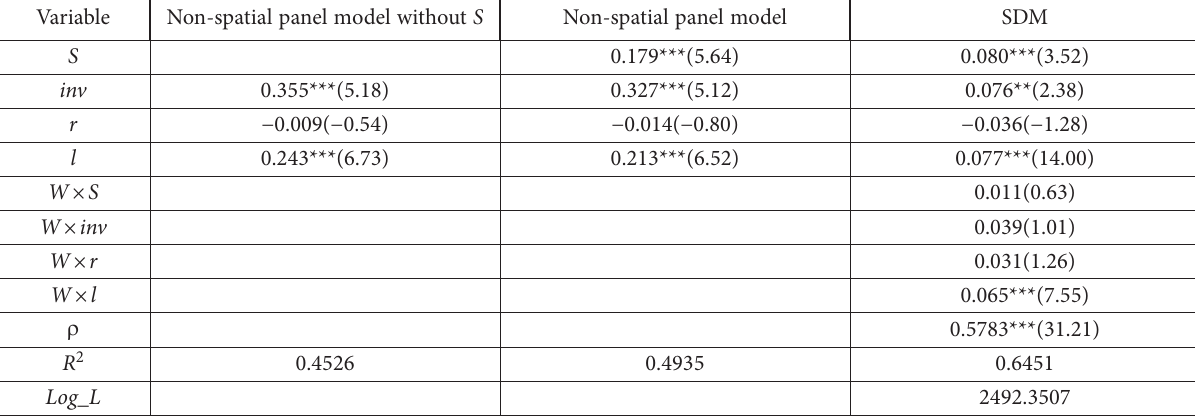
Table 6. Estimated results for whole